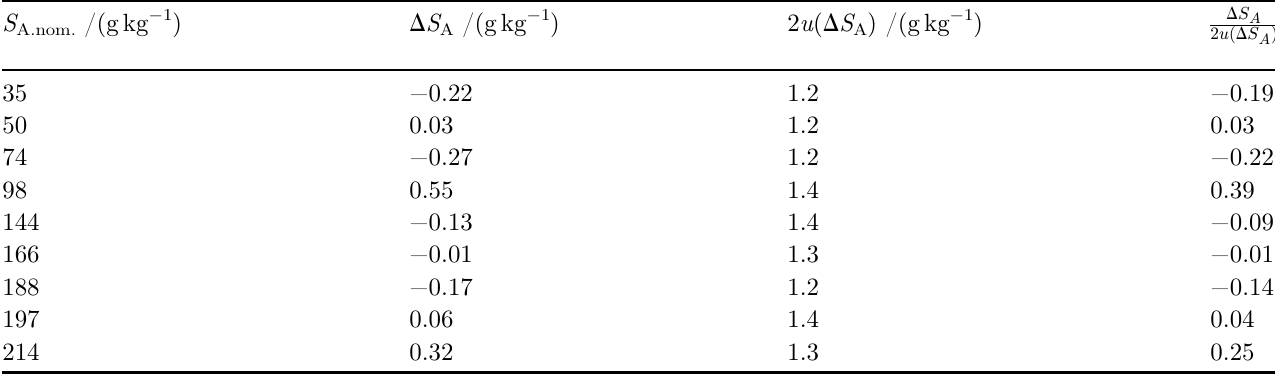
Table 5. Assessment of the metrological compatibility from the relative differences between pairs of salinity values by densimetry and by refractometry ( S solution.